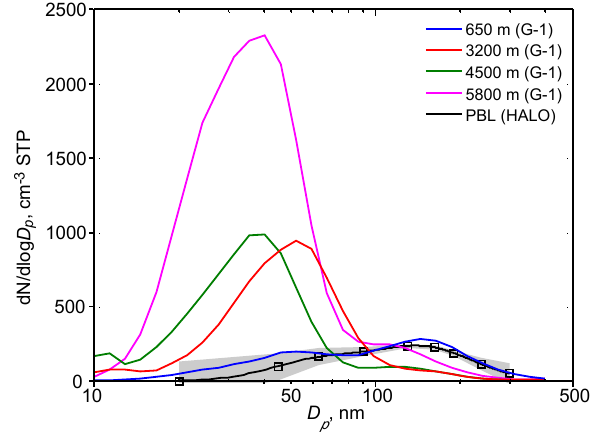
Figure 9. Size spectra: the black line shows the mean boundary layer DMPS size spectrum from a segment in the PBL on flight AC13 (16:55 to 17:18UTC). The square black symbols represent the mean; the grey shaded area the standard deviation of the mea- surements. The line is a logarithmic fit with modal diameters of 74 and 175nm. The colored lines represent size distributions from 0.65 to 5.8km from a G1 flight during GoAmazon (J. Wang et al., 2016).